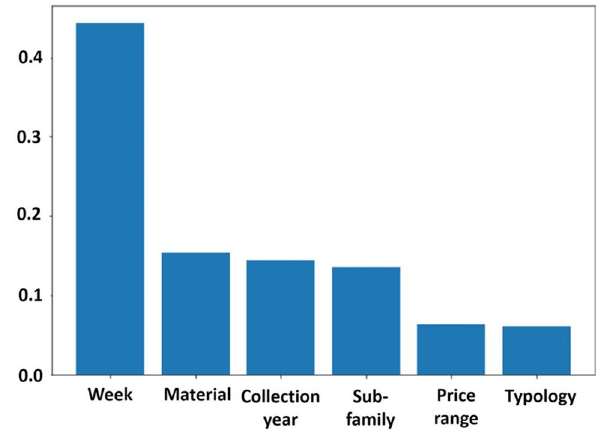
Fig. 11 Features importance for the Pants’